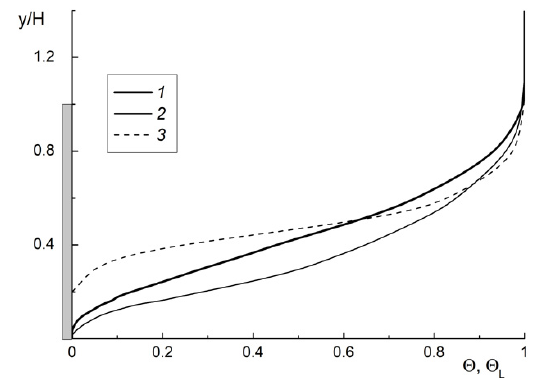
Figure 8. The transverse profiles of gas and droplet Θ L temperatures in the droplet-laden mist flow